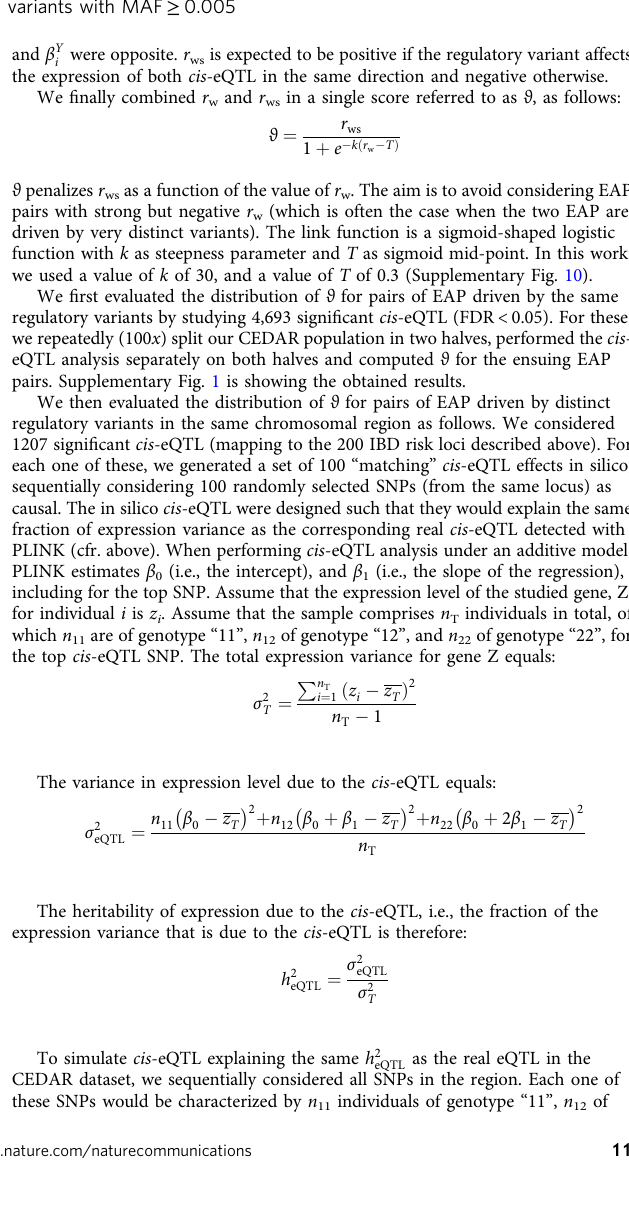
Fig. 8 Variants detected by sequencing the coding exons of 45 candidate genes. Variants are sorted in LoF (loss-of-function, i.e., stop gain, frame-shift, splice site), Damaging MS (missense variants considered as damaging by SIFT 5 and damaging or possibly damaging by Polyphen-2 6 ), Benign MS (other missense variants), and Synonymous. Blue: variants with MAF < 0.005, Red: variants with MAF ≥